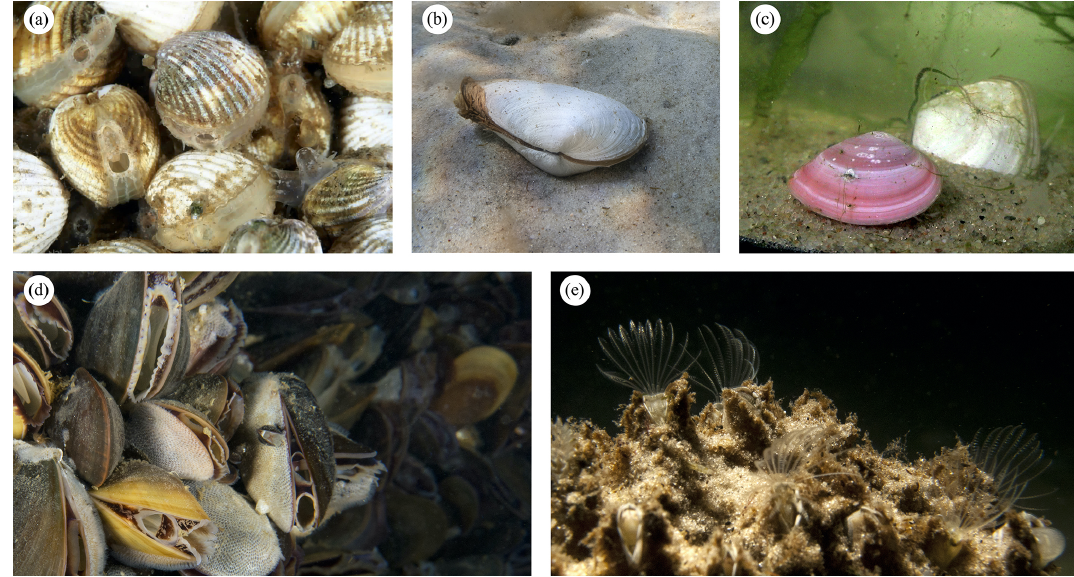
Figure 2. The investigated species photographed in situ: clams (a) Cerastoderma glaucum , (b) Mya arenaria , and (c) Limecola balthica ; mussels (d) Mytilus trossulus ; and barnacle (e) Amphibalanus improvisus